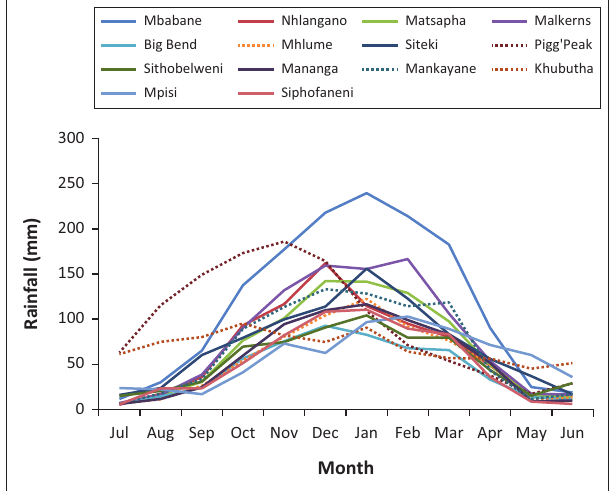
FIGURE 2: Mean historical monthly rainfall for Eswatini during the time period